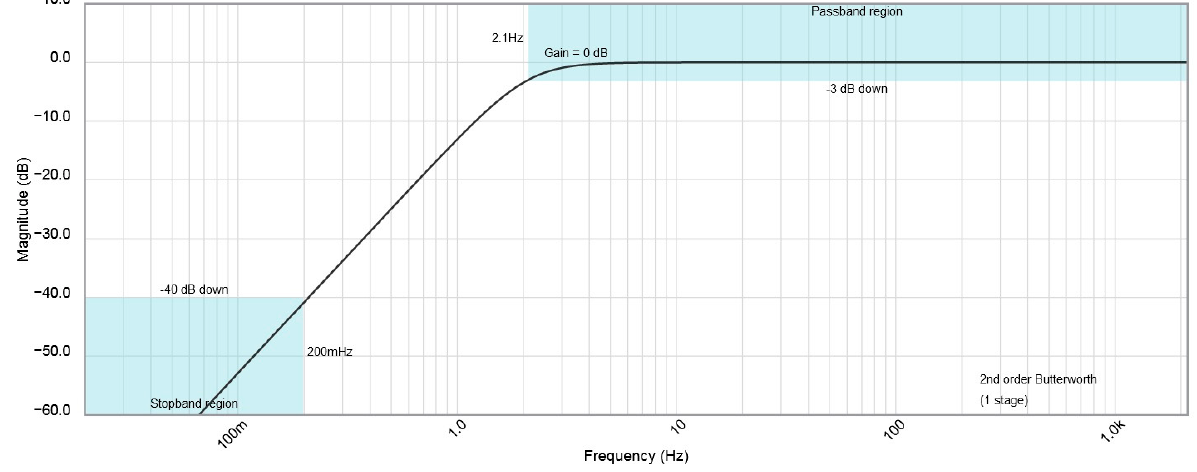
Figure 14. Simulation results of high-pass filter amplitude characteristics.